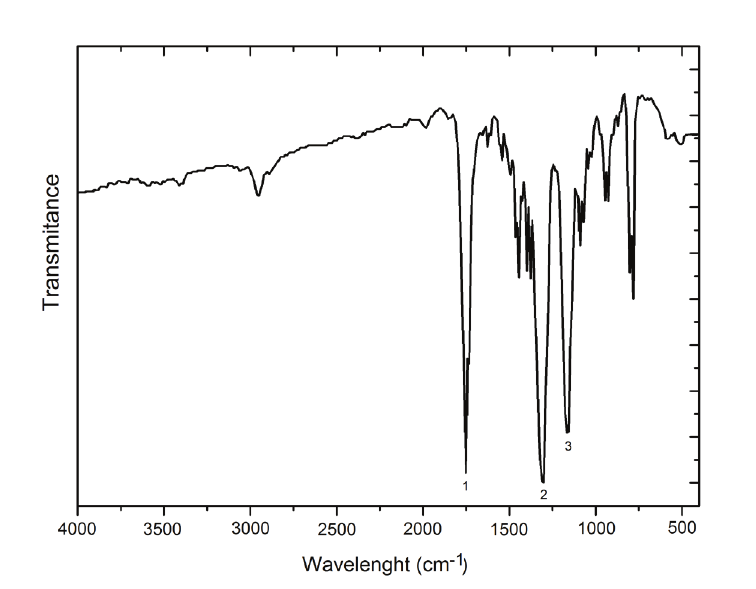
Figure 3. FTIR spectrum of polymer